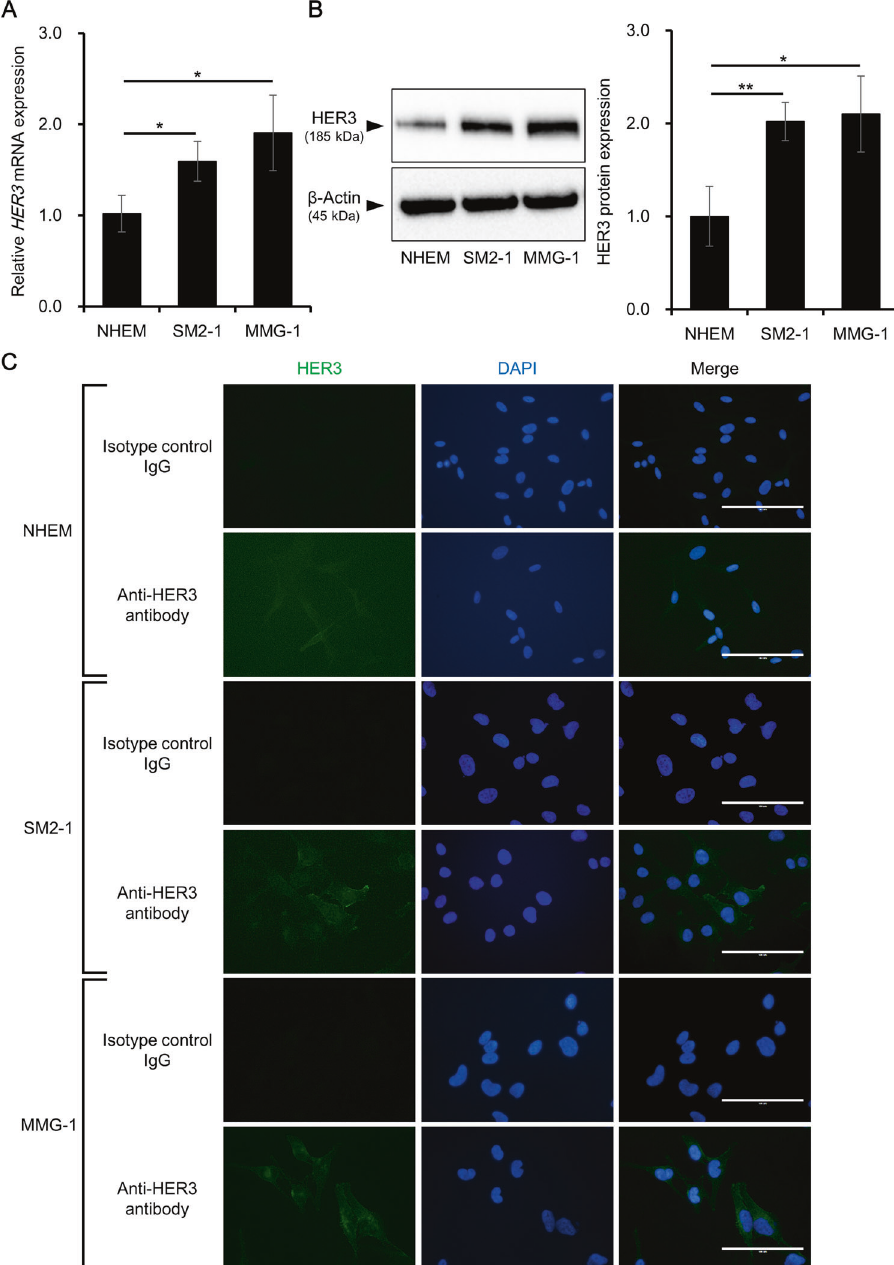
Fig. 2 HER3 expression in normal and malignant melanocytes. HER3 expression was evaluated in normal melanocytes and in AM cells. A HER3 mRNA expression in normal human epidermal melanocytes (NHEM), SM2-1, and MMG-1 cells. Experiments were independently repeated three times and mean ± SD of HER3 mRNA expression is shown. * p < 0.05. B HER3 protein expression in NHEM, SM2-1, and MMG-1 cells. Experiments were independently repeated three times and representative blot images (left) and mean ± SD of HER3 protein expression (right) are shown. Original uncropped blot images are shown in Supplementary Fig. S1. * p < 0.05 and ** p < 0.01. C Immunocytochemical staining of HER3 in NHEM, SM2-1, and MMG-1 cells. Experiments were independently repeated three times and representative images of HER3 (green, left panels), DAPI (blue, middle panels), and merged images (right panels) are shown. Scale bars = 100 μ